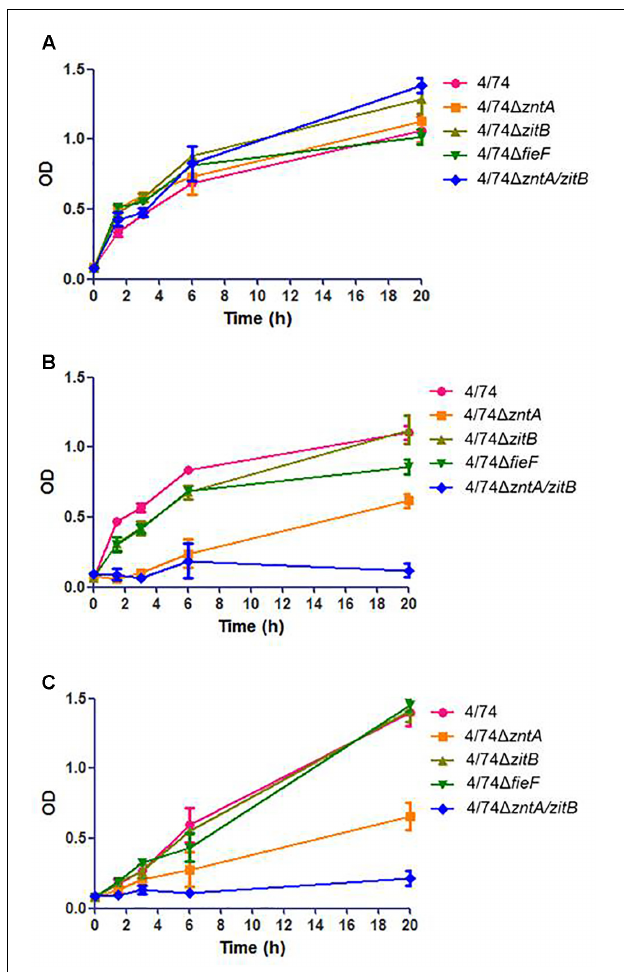
FIGURE 1 | Analysis of the growth of the WT and zinc export mutants in: (A) LB. No statistically significant difference was observed between the WT and mutants. (B) LB supplemented with 0.25 mM ZnCl 2 . (C) LB supplemented with 1.5 mM CuSO 4 . When LB was supplemented with high concentrations of metals (ZnCl 2 or CuSO 4 ) the OD values for the mutants 4/74 (cid:49) zntA and 4/74 (cid:49) zntA/zitB were significantly lower than those observed for the WT at